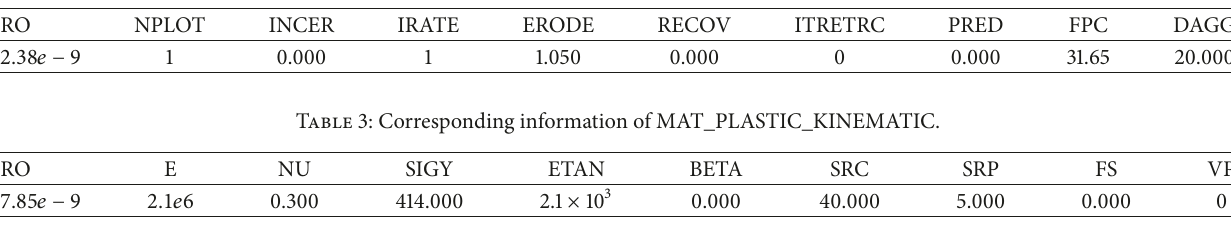
Table 2: Corresponding information of MAT_CSCM_CONCRETE.